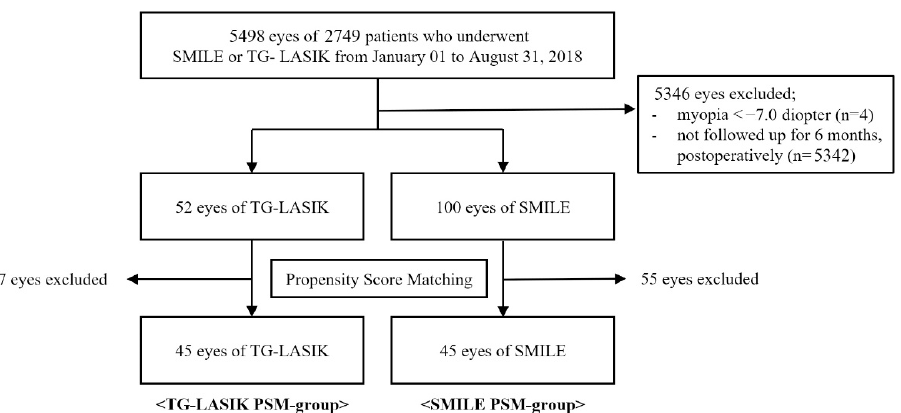
Figure 1. Flowchart showing patients receiving TG-LASIK and SMILE for propensity score matching analysis (TG-LASIK, topography-guided laser-assisted in situ keratomileusis; SMILE, small-incision lenticule extraction; PSM, propensity score matching).